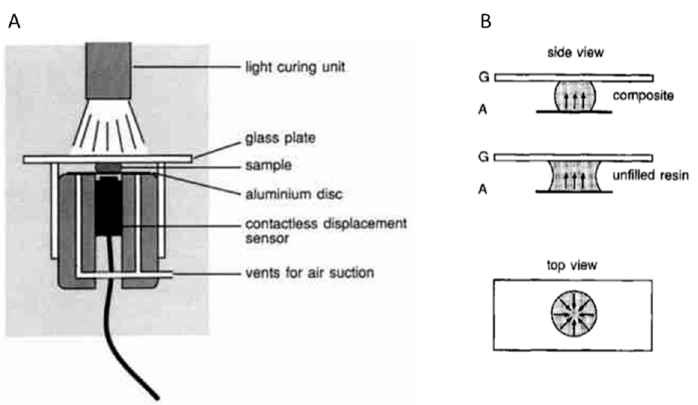
Figure 6. A : Schematic set-up of a linometer. B : Side and top view of the shape of a composite and unfilled resin sample placed between the glass slide and aluminum disk of a linometer. Both pic- tures (referred to as A and B ) constituting this Figure 6 have been reprinted from reference [28] with permission from Elsevier.